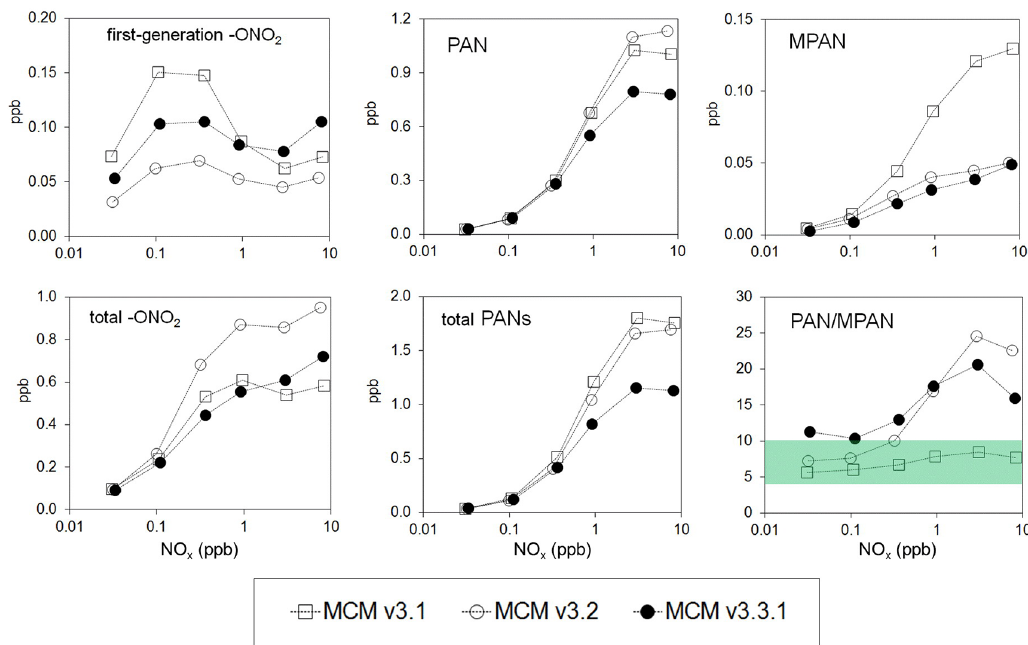
Figure 12. Comparison of the performances of MCM v3.1, MCM v3.2 and MCM v3.3.1, showing the NO x dependence of the daylight- averaged mixing ratios of the organic oxidised nitrogen reservoirs, nitrates (–ONO 2 ) and PANs, and the daylight-averaged PAN / MPAN ratio. The first-generation nitrates are specifically those formed from the reactions of NO with first-generation peroxy radicals (denoted “ISOPO2” in Fig. 10). The shaded band in the PAN / MPAN panel represents the typical range of reported observed values in isoprene- dominated environments (see